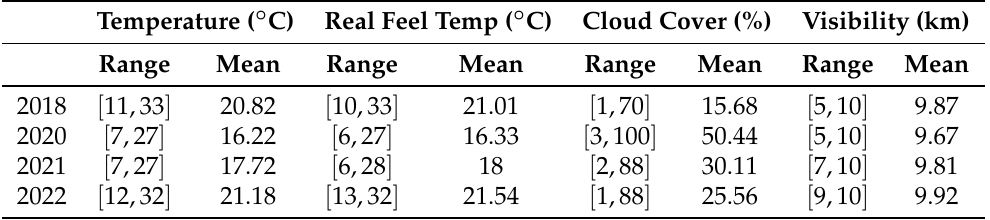
Table 2. Descriptive statistics for the temperature, cloud cover, and visibility in Skopje in May 2018,